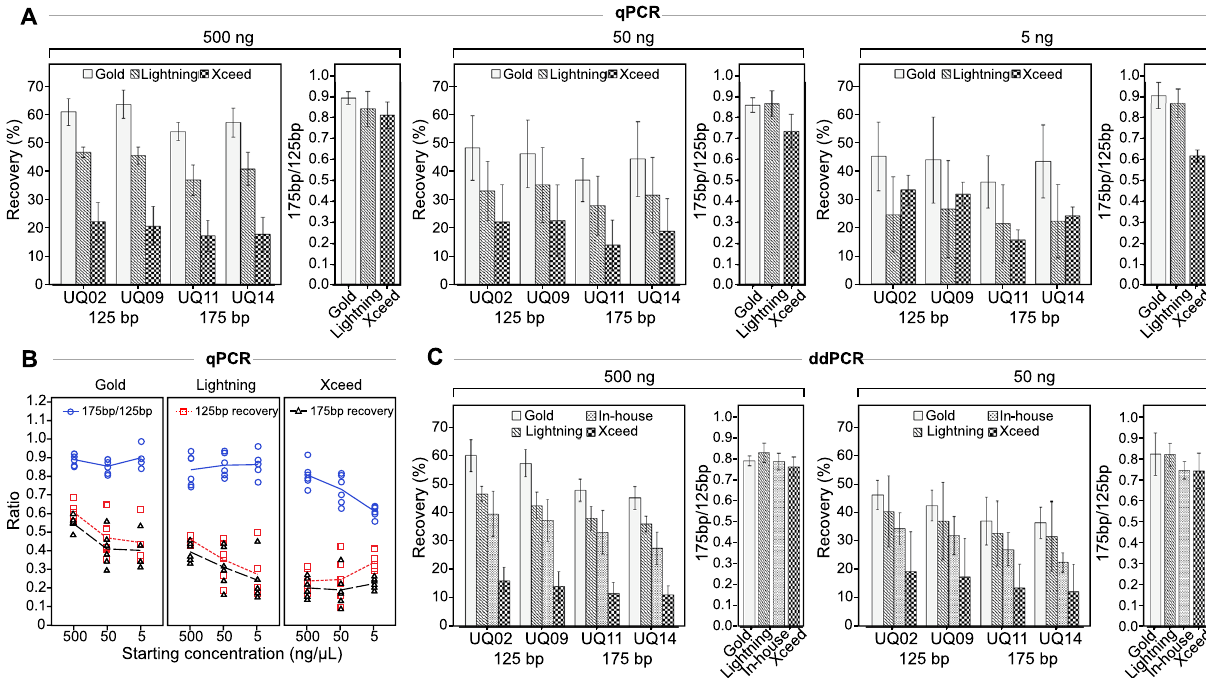
Figure 5. Universal assay comparisons of DNA recovery and fragmentation by bisulfite conversion kits. ( A ) Recovery and fragmentation across different starting concentrations as measured by universal quantitation assays in 4-plex qPCR. ( B ) Plots comparing the recovery and fragmentation trends from qPCR data across decreasing starting concentrations. Recovery data points are averages of the two universal assays for each amplicon length and these values were divided to determine the [175 bp]/[125 bp] ratios. ( C ) Recovery and fragmentation measured by ddPCR 4-plex. Also includes results from in-house bisulfite protocol. ( A , C ) Each conversion was conducted in six replicates per concentration for each kit. [175 bp]/[125 bp] fragmentation ratios were calculated by dividing the average copies of the two 175 bp assays by the average of copies the two 125 bp assays. Error bars represent one standard deviation.